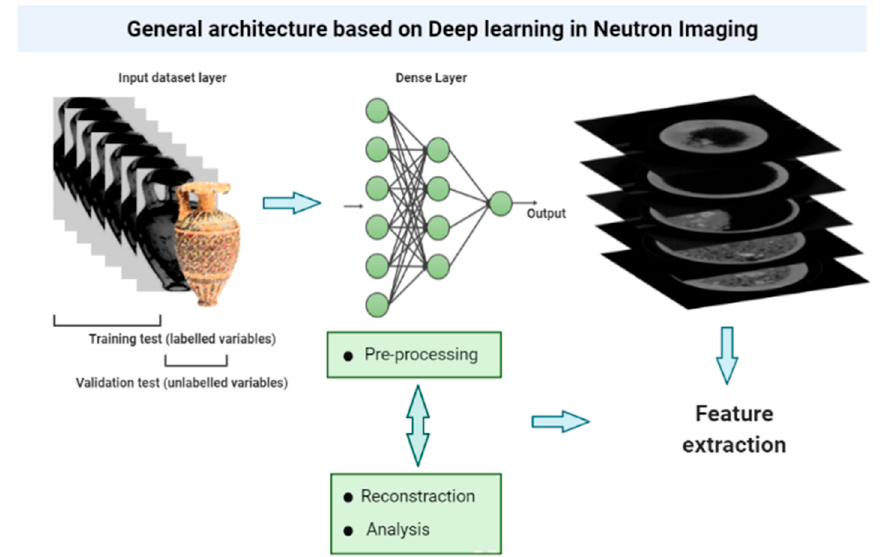
Figure 2. General overview of the Deep Learning architecture in Neutron Imaging applications. Training datasets that correspond to labelled variables are able to validate new datasets where the variables are still unlabelled, predicting the clustering of belonging by the similarity of their distribution along the regression line.